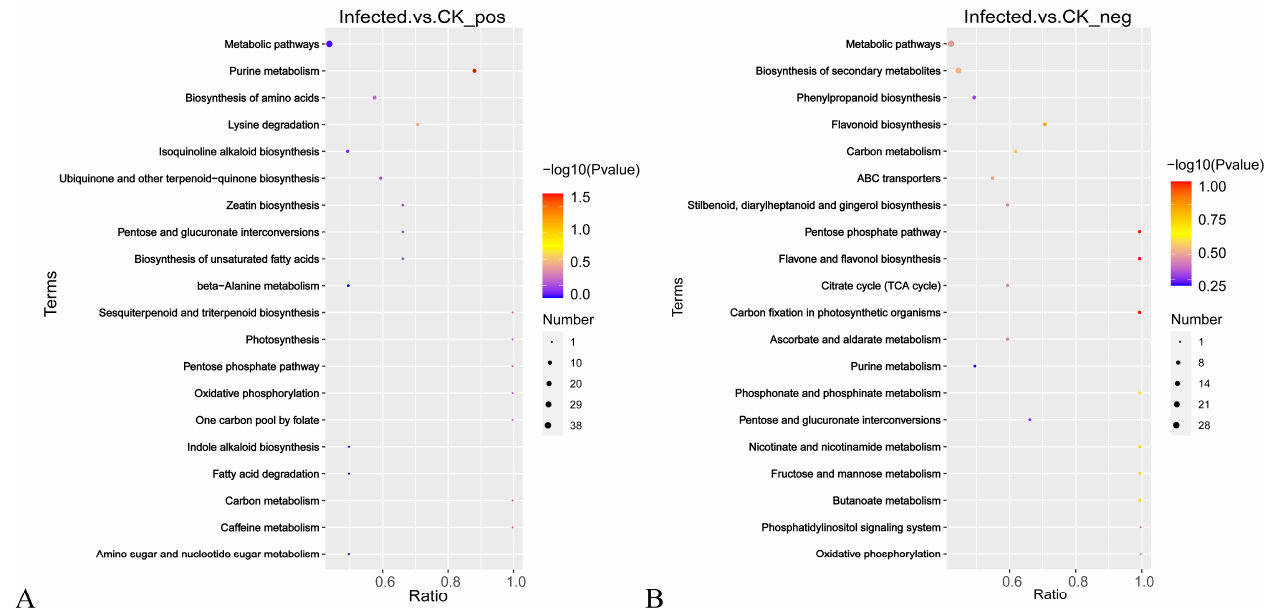
Figure 6. DEM annotation diagram. Note: KEGG pathway classification of DEM in pos ( A ) and neg ( B ).